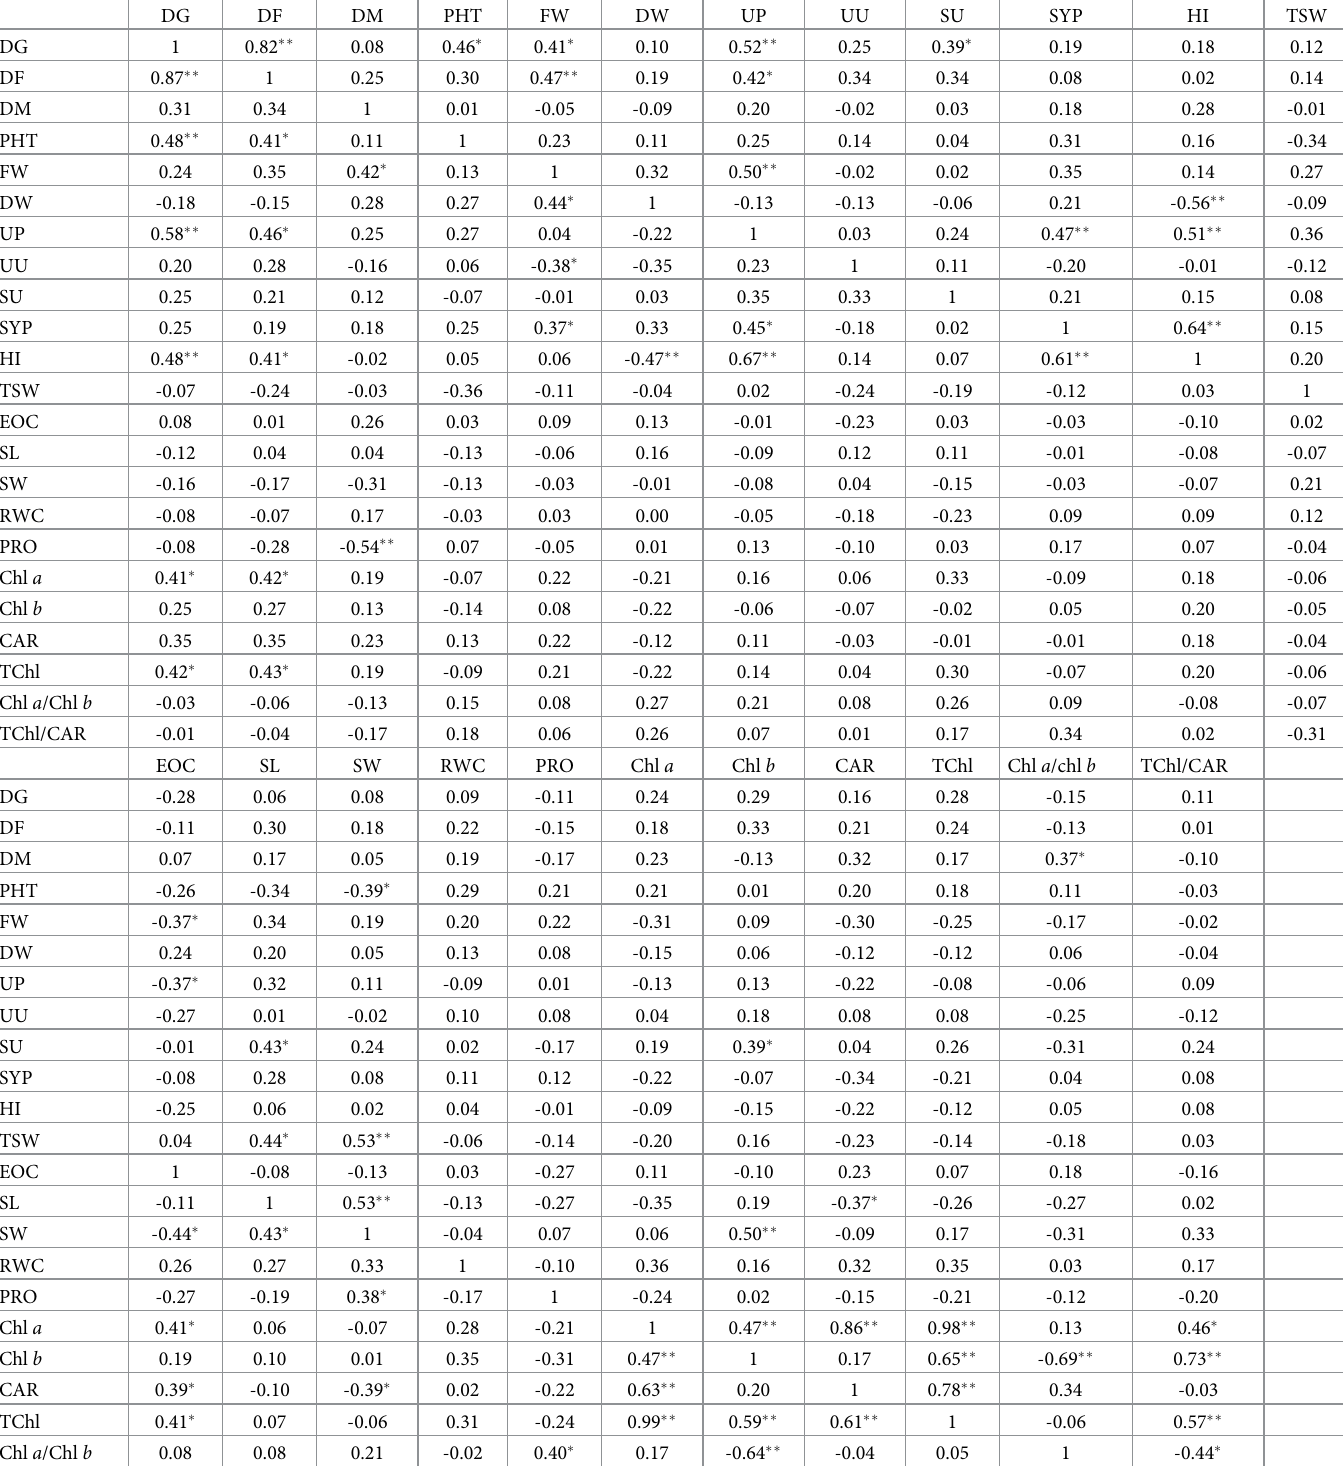
Table 6. Correlation coefficients among morphological, agronomic, and physiological traits of selfed (S1) population of fennel in normal (above diagonal) and water deficit condition (below